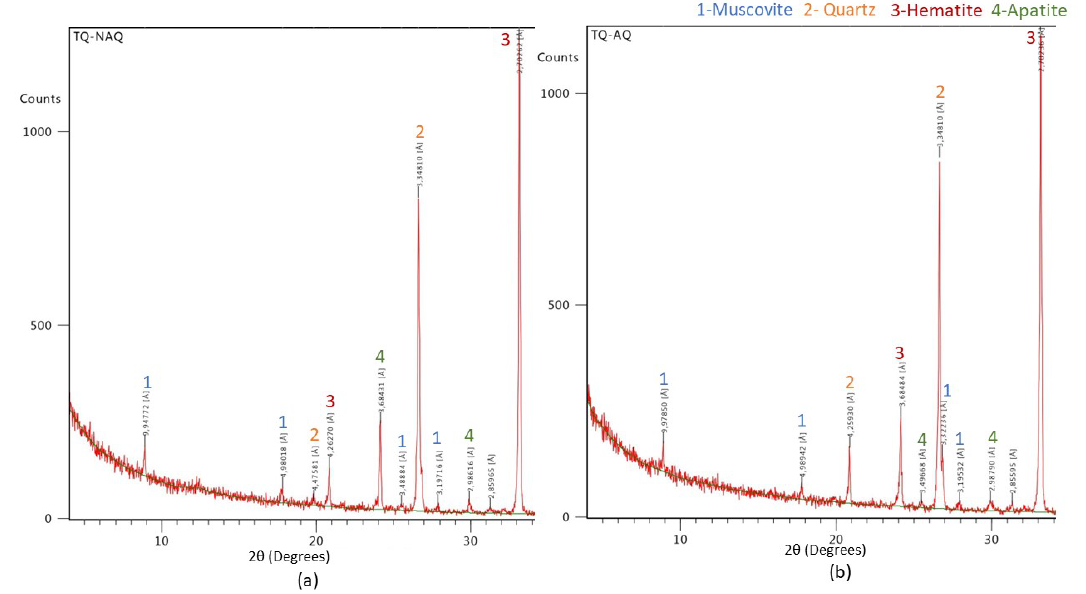
Figure 7. XRD powder diffraction analysis with identified peaks: ( a ) TQ sample not subjected to heating/cooling cycles; ( b ) TQ sample subjected to heating/cooling